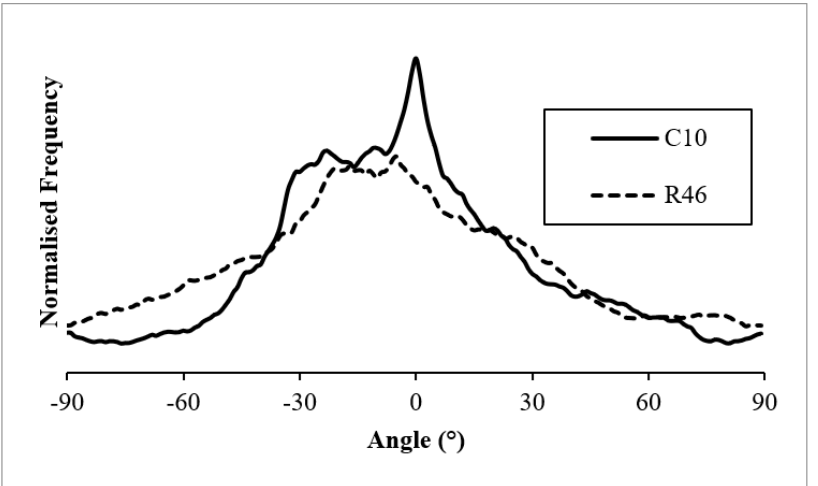
Figure 9. Graphs representing fibre orientation distribution profiles obtained for the fibre mats made using DSF with selected nozzles (R46 and C10). Scanning electron micrographs of the fibre mats were used for the analysis.